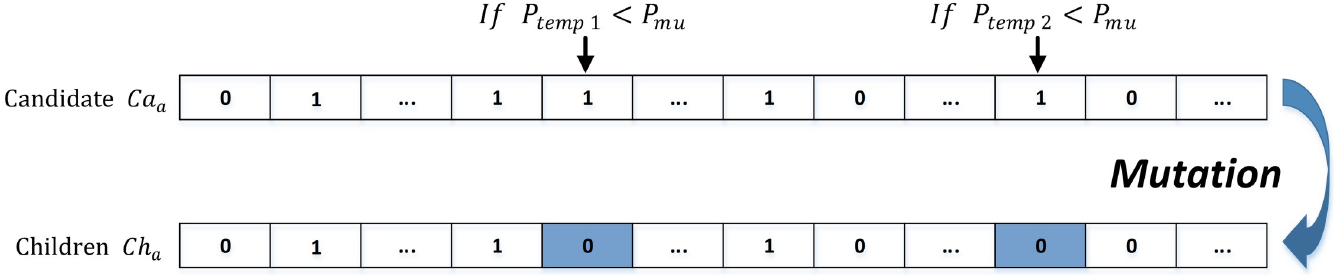
Fig 3. Mutation operator with a small